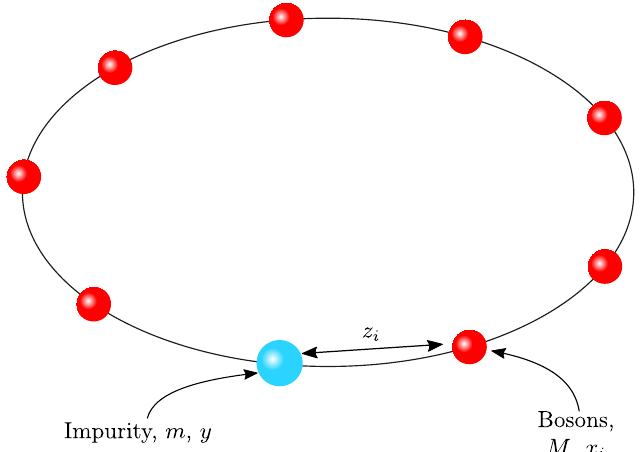
Figure 2: Illustration of the one-dimensional Bose-polaron problem: N bosons and a single impurity on a ring of length L . The mass of the impurity atom is m while the mass of a boson is M . The coordinates of the impurity and the bosons are y and { x respectively. For convenience, the problem is solved using the set of coordinates { z which describe the relative distances between the impurity and the